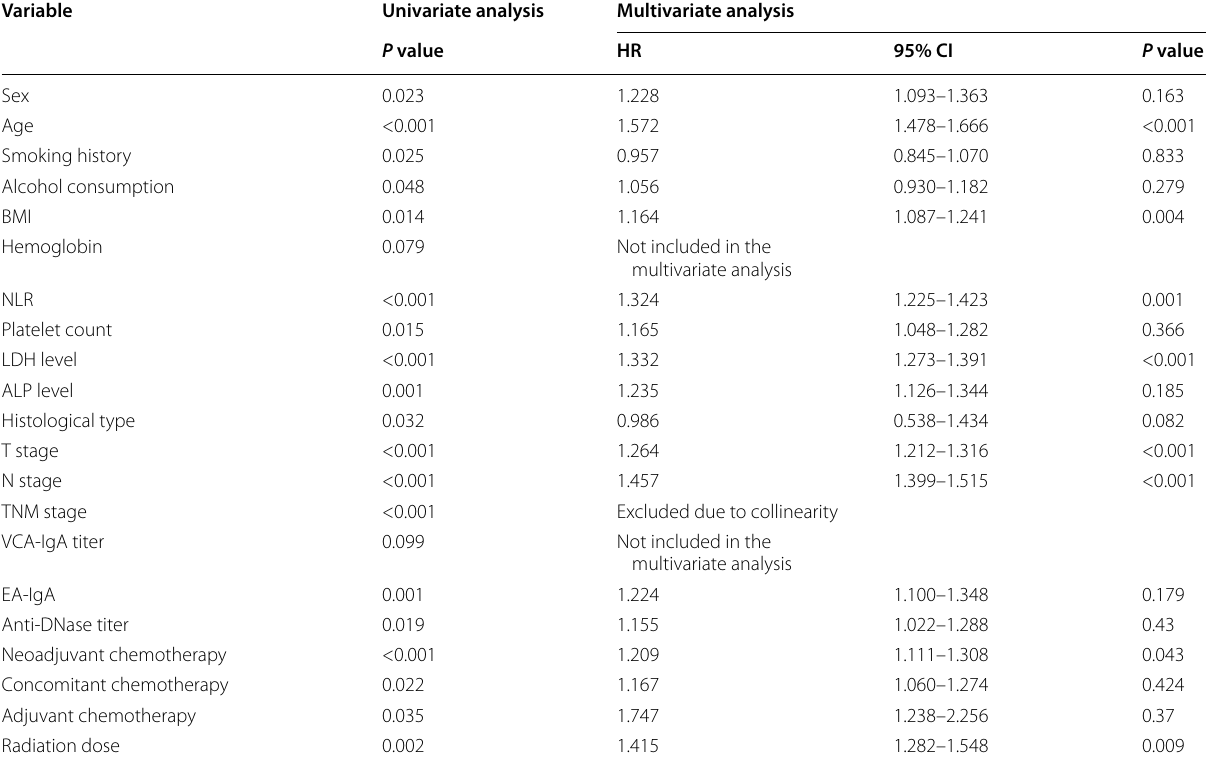
Table 2 Cox univariate and multivariate analyses of prognostic factors for the overall survival of non-metastatic naso- pharyngeal carcinoma patients after